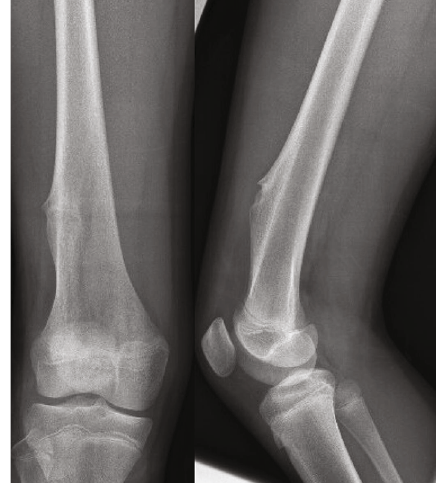
Figure 7: AP and lateral plain radiographs of the right distal femur demonstrate a sessile-appearing lesion on the anterolateral aspect of the distal femur consistent with osteochondroma.